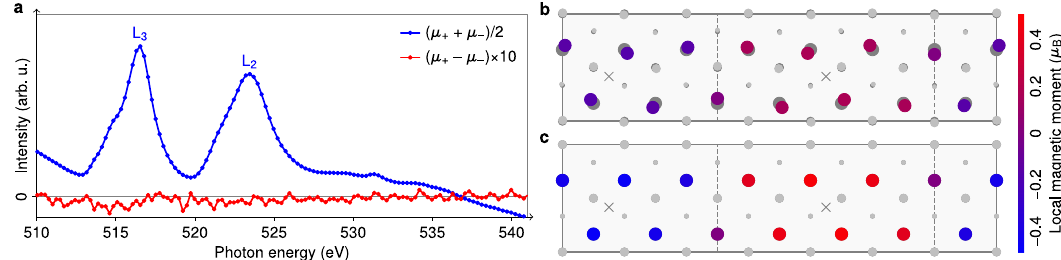
Fig. 6 Magnetic properties of monolayer 1T-VS 2 . a Plotted in blue is the X-ray absorption signal averaged over both helicities and directions of the B fi eld. The corresponding XMCD is shown in red. All measurements have been conducted in B fi elds of ±9 T and at a temperature of 7 K. b , c Possible SDW pattern with ( b ) and without CDW ( c